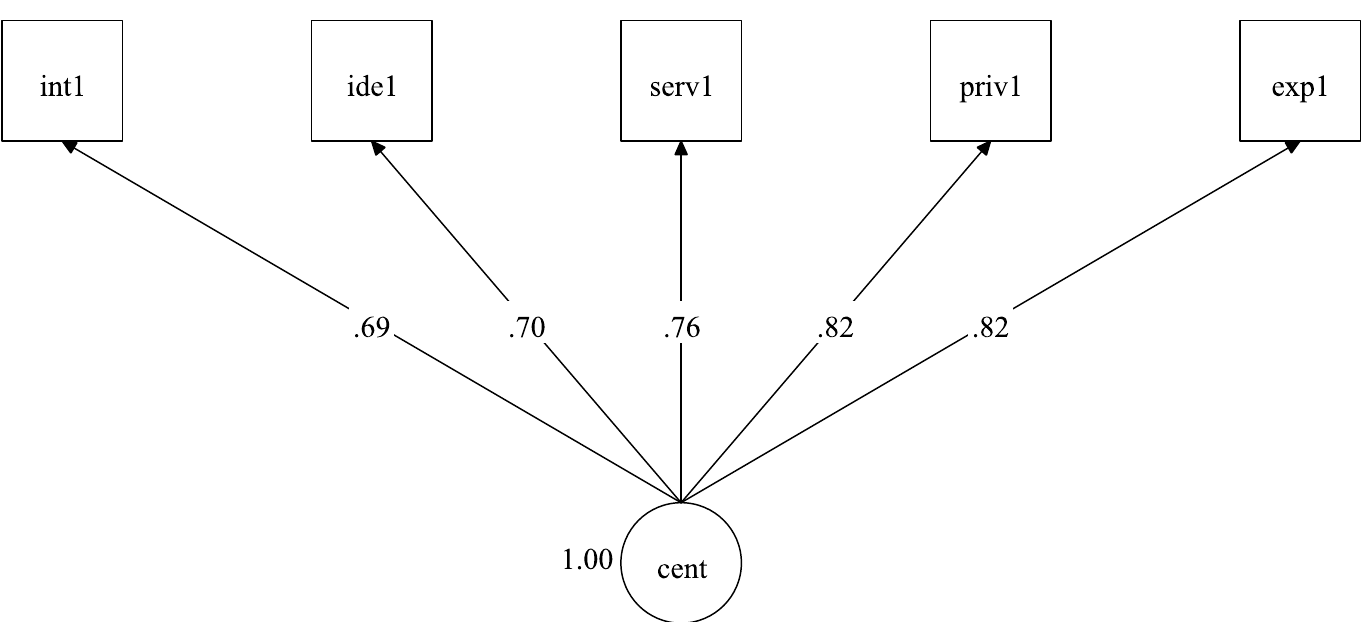
Figure A3. Results of the confirmatory factor analysis of the CRS-5. The numbers in the plot represent standardized estimates. Cent = centrality of religiosity; int = intellect; ide = ideology; serv = public practice; priv = private practice; exp = experience. The number after the item name indicates the position of the item within the core dimension items. Squares depict manifest and circles latent variables. Residual arrows are not shown for the manifest variables. The numbers on the arrows are factor loadings. The model is identified by setting the variance of the latent variable “cent” to 1.00. All reported estimates are significant at least α ≤ 0.05